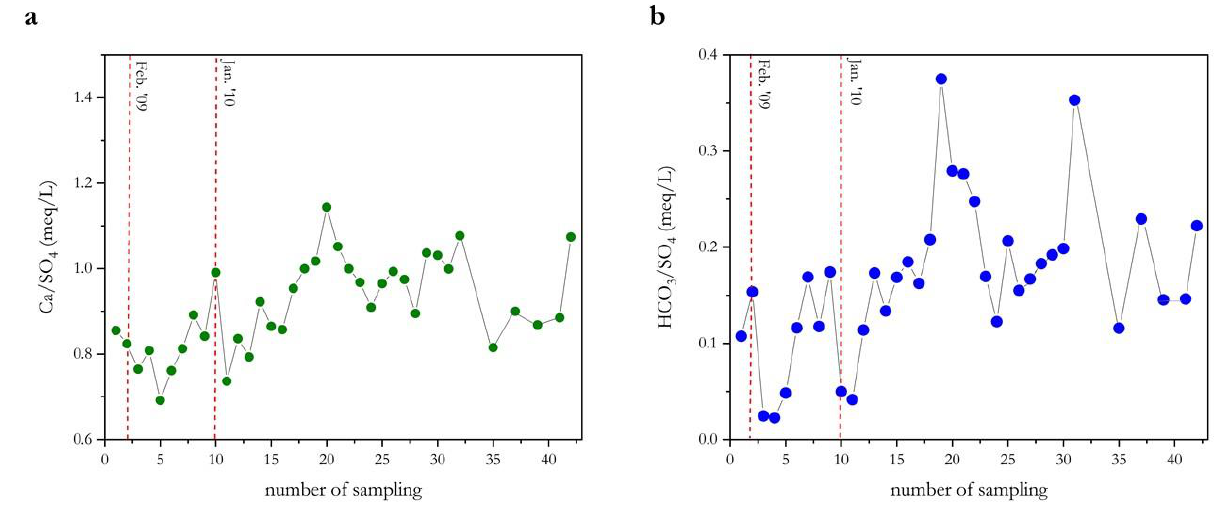
Figure 6. Temporal variations of the Ca/SO 4 ( a ) and HCO 3 /SO 4 ( b ) ratios (in meq L −1 ). The IDs refer to the different surveys (see Table 1).